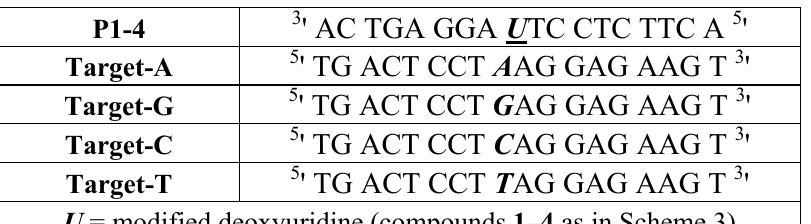
Table 2. Oligonucleotides used in the